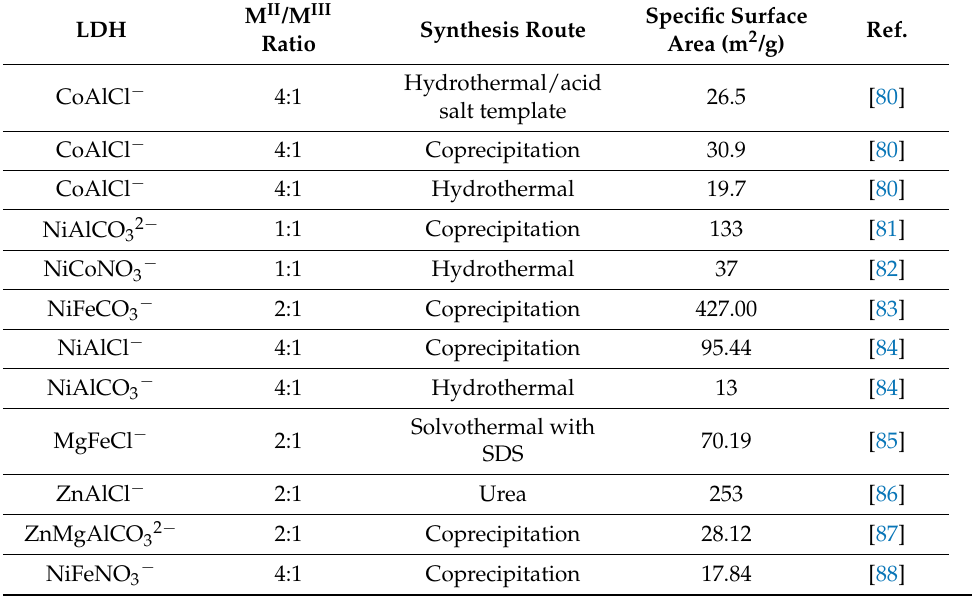
Table 1. Correlation between the chemical composition and synthesis route of LDHs and surface area